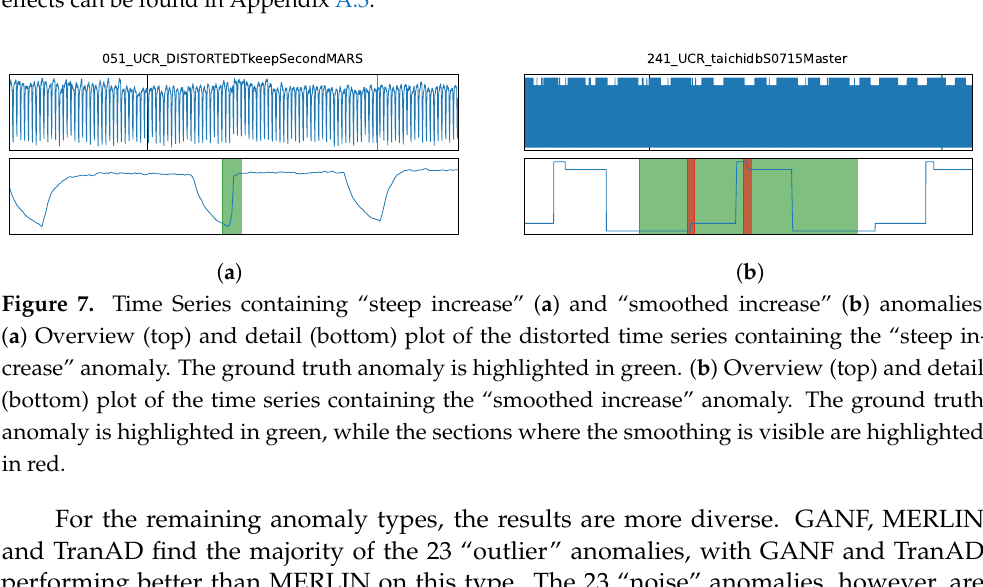
Figure 6. The heatmaps show the macro-averaged AUC ROC, F1 and UCR scores for the 16 annotated anomaly types over six repetitions of the experiment. Next to the anomaly type, the number of times series containing that type is shown in parenthesis. The standard deviations resulting from random effects can be found in Appendix A.3.